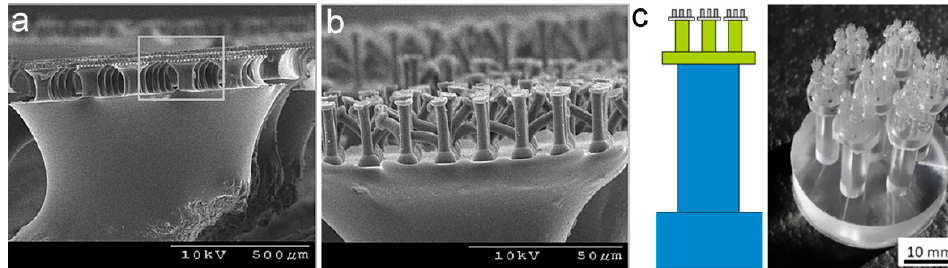
Figure 4. Three ‐ level self ‐ similar pillar structures. Scanning electron microscopy (SEM) images of ( a ) Figure 4. Three-level self-similar pillar structures. Scanning electron microscopy (SEM) images of ( a ) three ‐ level polyurethane (PU) pillars with mushroom ‐ shaped tips, and ( b ) the collapse phenomenon three-level polyurethane (PU) pillars with mushroom-shaped tips, and ( b ) the collapse phenomenon of the third ‐ level. Reprinted with permission from [82]. Copyright (2009) American Chemical Society; of the third-level. Reprinted with permission from [82]. Copyright (2009) American Chemical ( c ) Schematic and image of the three ‐ level polydimethylsiloxane (PDMS) macropillar adhesive. Society; ( c ) Schematic and image of the three-level polydimethylsiloxane (PDMS) macropillar adhesive. Reproduced with permission from [93]. Reproduced with permission from